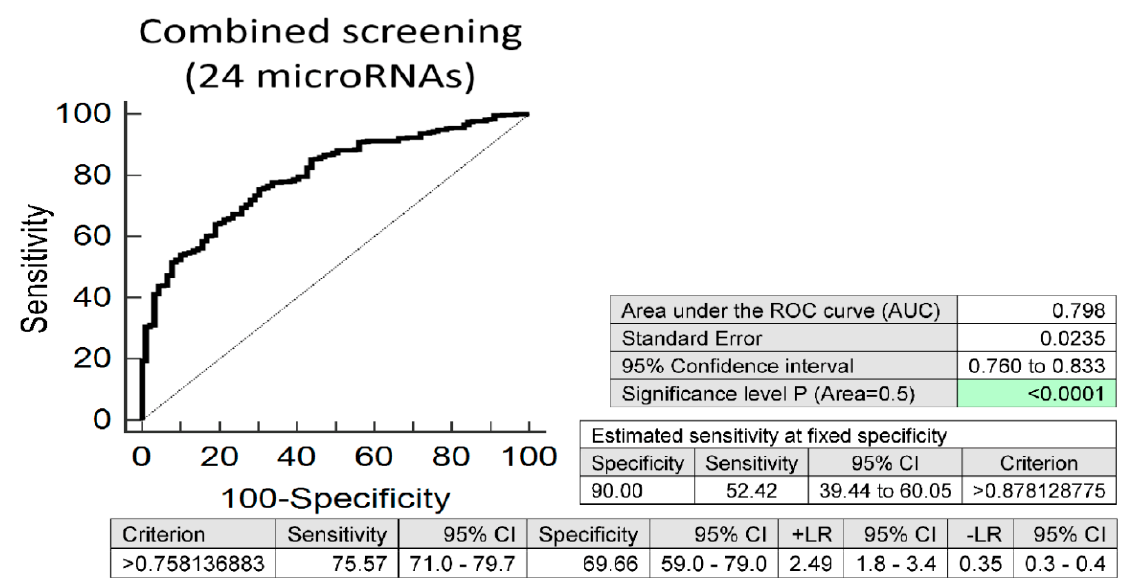
Figure 1. Aberrant microRNA expression profile in mothers after complicated pregnancies (gestational diabetes mellitus, gestational hypertension, preeclampsia, fetal growth restriction, preterm prelabor rupture of membranes, and/or spontaneous preterm birth). Combined microRNA screening revealed that at 10.0% FPR 52.42% mothers with a history of any pregnancy-related complication had substantially altered expression profile of miR-1-3p, miR-16-5p, miR-17-5p,